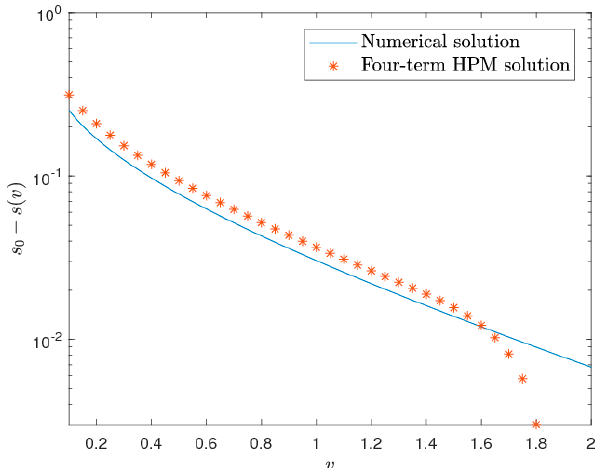
Figure 8. Comparison between the Theis solution and the four terms of HPM-based solution for the selected case. Table 3. Comparison between four terms of the HPM-based approximation and Theis solution for the selected case.